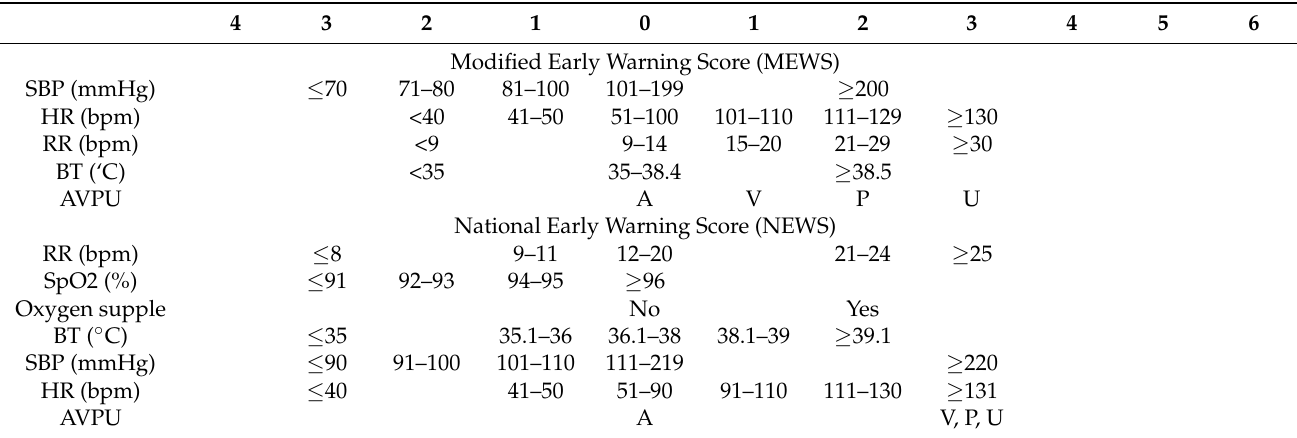
Table 1. Comparison of vital signs used in MEWS, NEWS, and